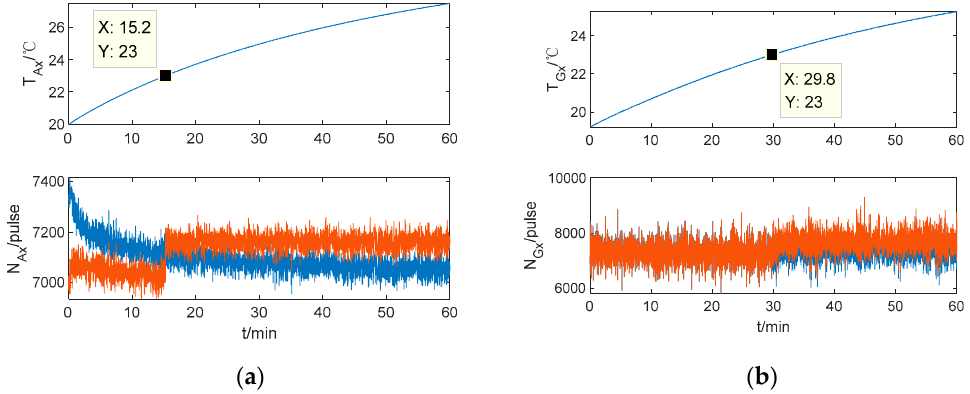
Figure 7. The x -axis IMU outputs based on method (1). ( a ) The x -axis accelerometer output. ( b ) The x -axis gyroscope output.